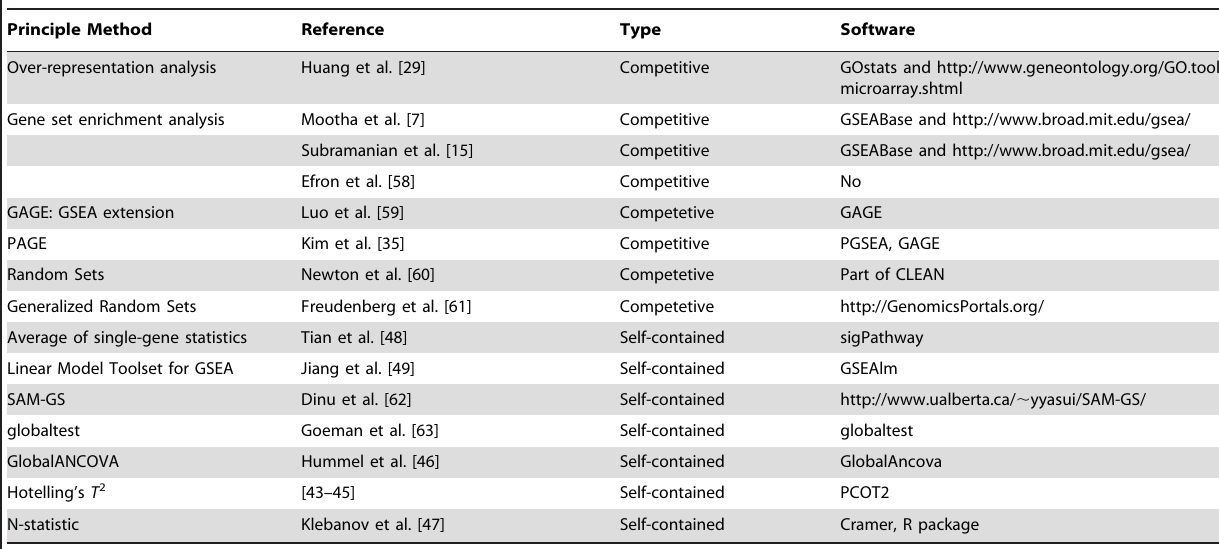
Table 1. Overview of different pathway-based